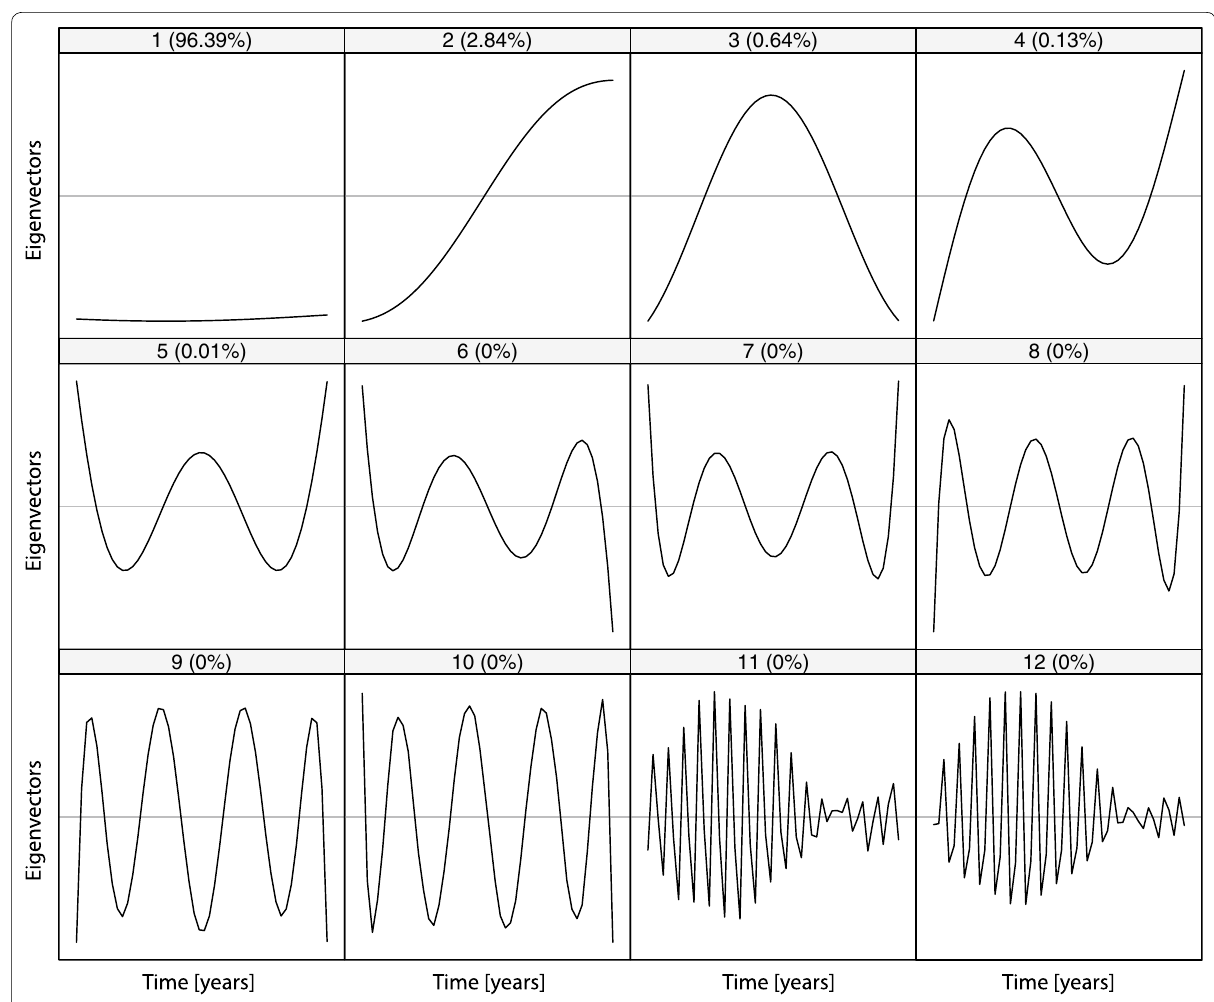
Fig. 13 The first 12 eigenvectors of the toroidal flow temporal variability. The x -axes of each subplot represent the model interval (1957–2020). The percentages of the partial variance of each eigenvector are given in the top bar of the individual